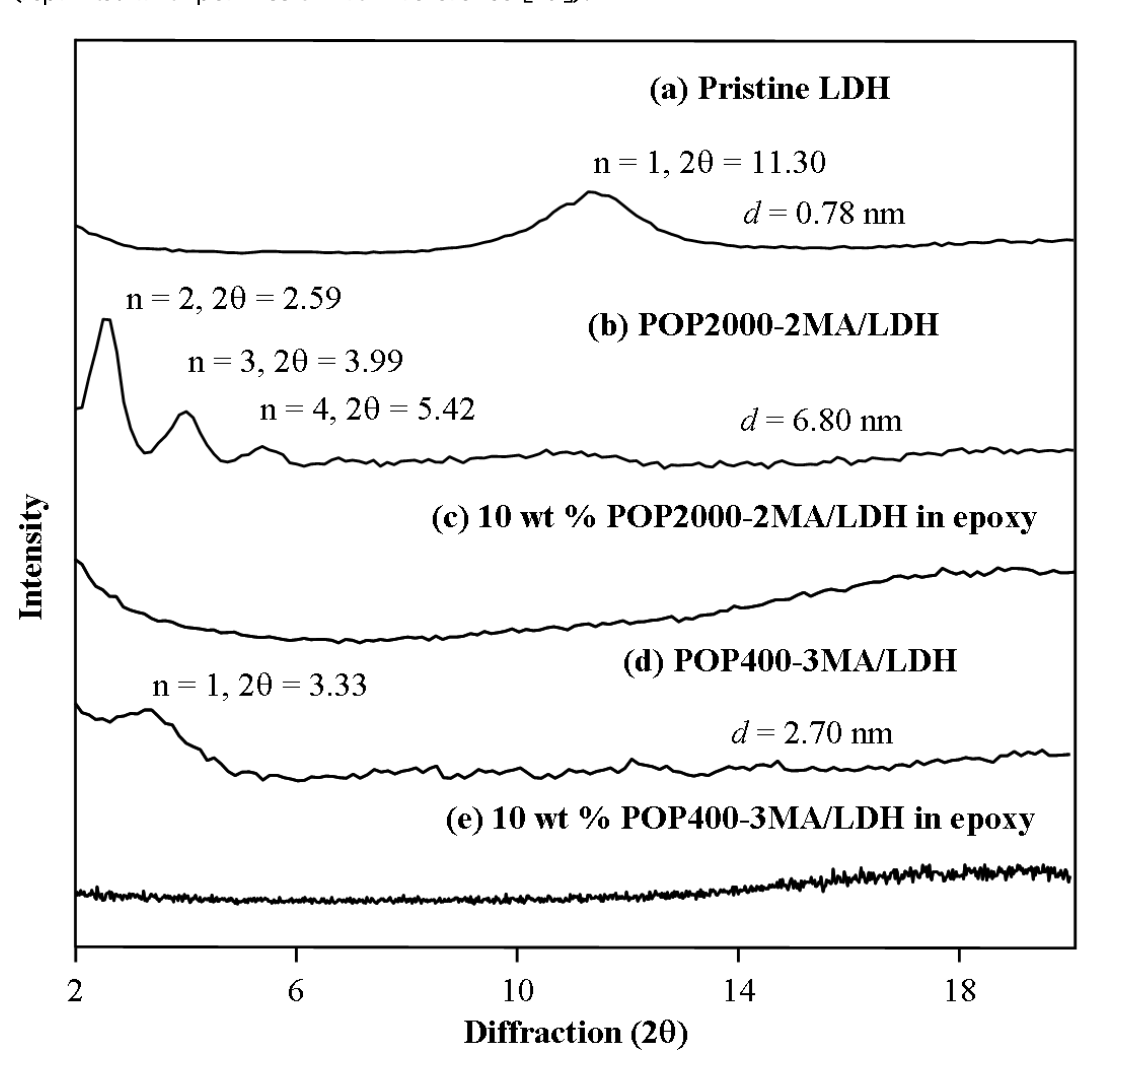
Figure 6. X-ray diffraction patterns of organo-LDH initiated epoxy self-curing material (reprinted with permission from reference